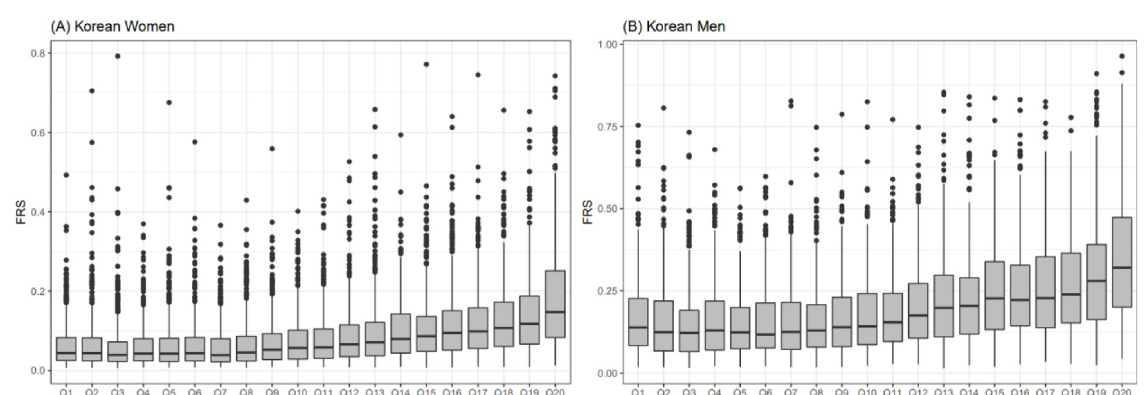
Fig 4. Relationship between albuminuria and FRS in Korean women (A) and men (B). Urine albumin-to-creatine ratio was categorized into 20 groups (x-axes) based on ascending order. FRS was calculated based on the equation provided by a study [22]. Abbreviation: FRS, Framingham risk